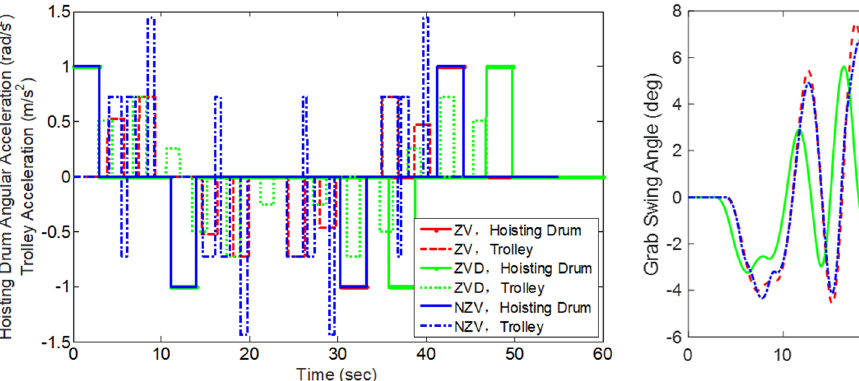
Fig. 5. Swing angle curves of the grab.